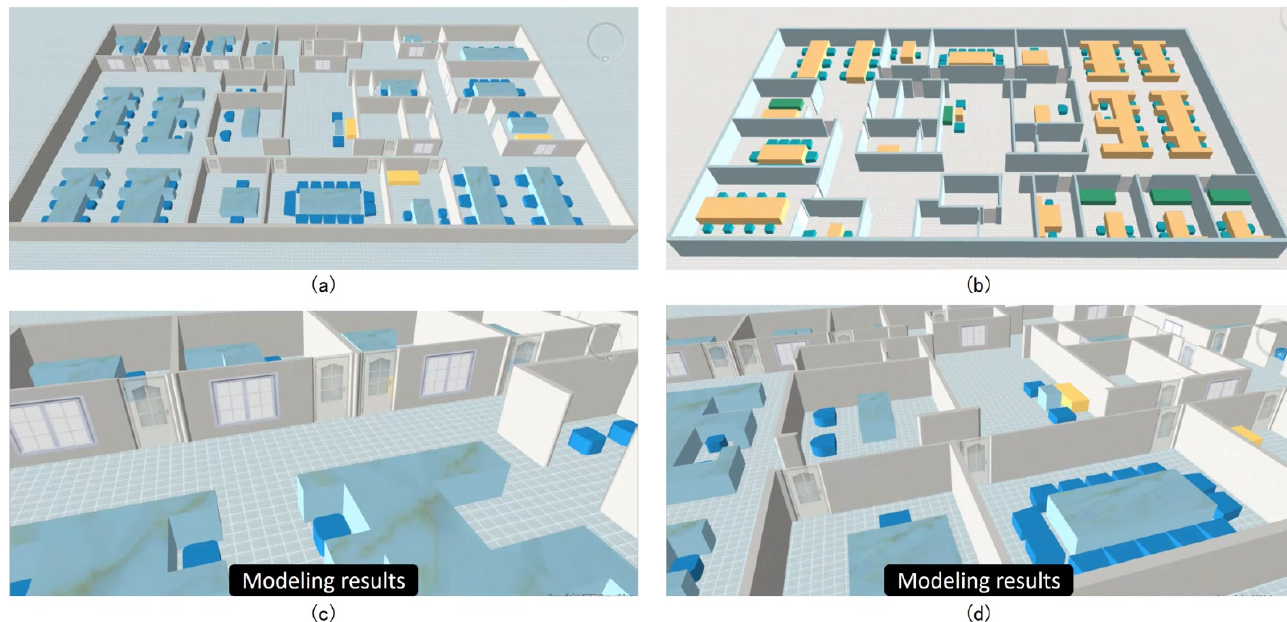
Figure 16. The modeling results of Indoor 3D model obtained based on ARSnap in unity: ( a ) modeling results after capturing the first-floor indoor model; ( b ) modeling results after capturing the second-floor indoor model; ( c ) details of modeling results of indoor model on the first floor; ( d ) details of modeling results of indoor model on the second floor.